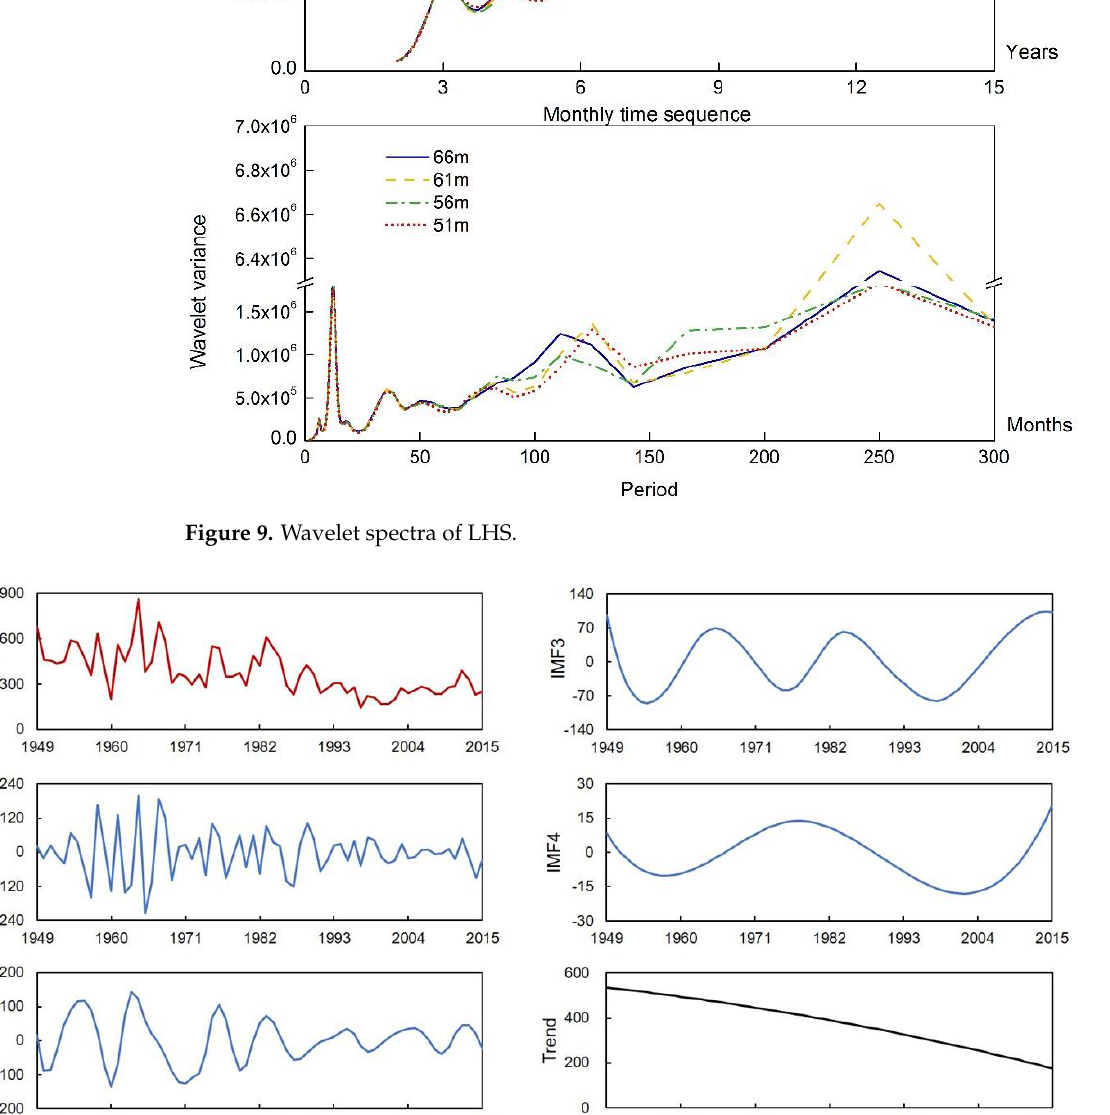
Figure 10. Empirical mode decomposition for the 67 a series of HHS.